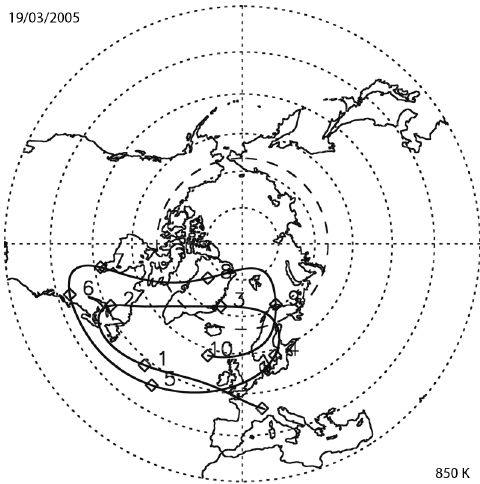
Fig. 8. 10-day NASA/GSFC back trajectory at 850 K arriving over Testa Grigia on 19 March, 2005. Five trajectories were calculated and only the resulting average trajectory is shown (see text for details). Numbers along the trajectory indicate the distance in days before the arrival of the air parcel at Testa Gri- gia. Back trajectory calculations are from the NASA/Goddard Space Flight Center (NASA/GSFC) «automailer» system initiated with NCEP reanalysis meteorological data (Schoeberl and Sparling,